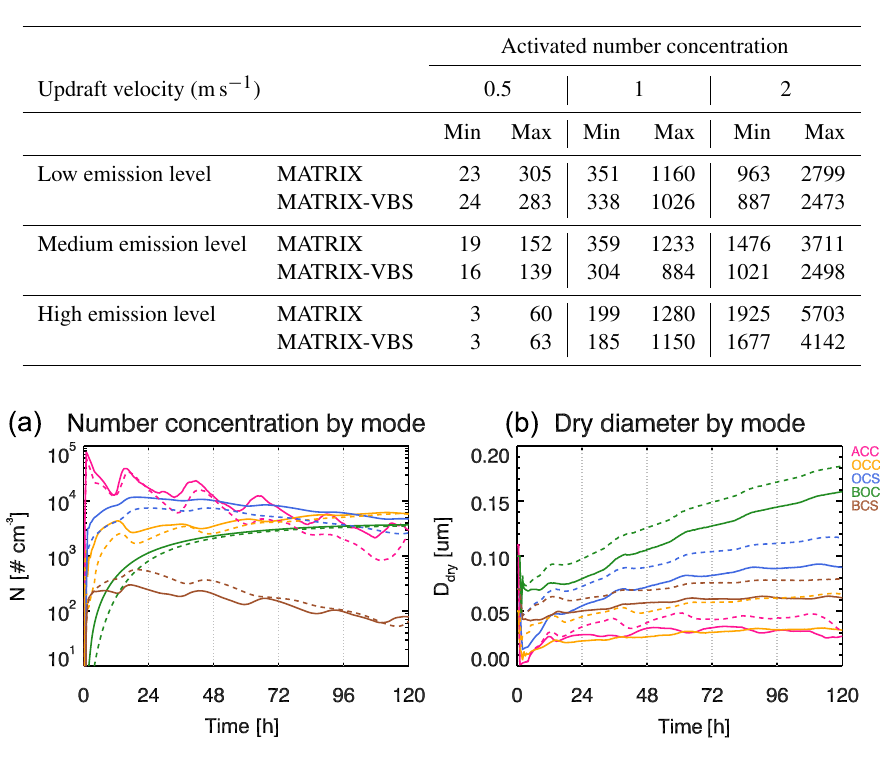
Table 4. Minimum and maximum of average activated number concentration over the last 24h of MATRIX and MATRIX-VBS with low-, medium-, and high-level emissions at updraft velocities of 0.5, 1, and 2ms − 1 .